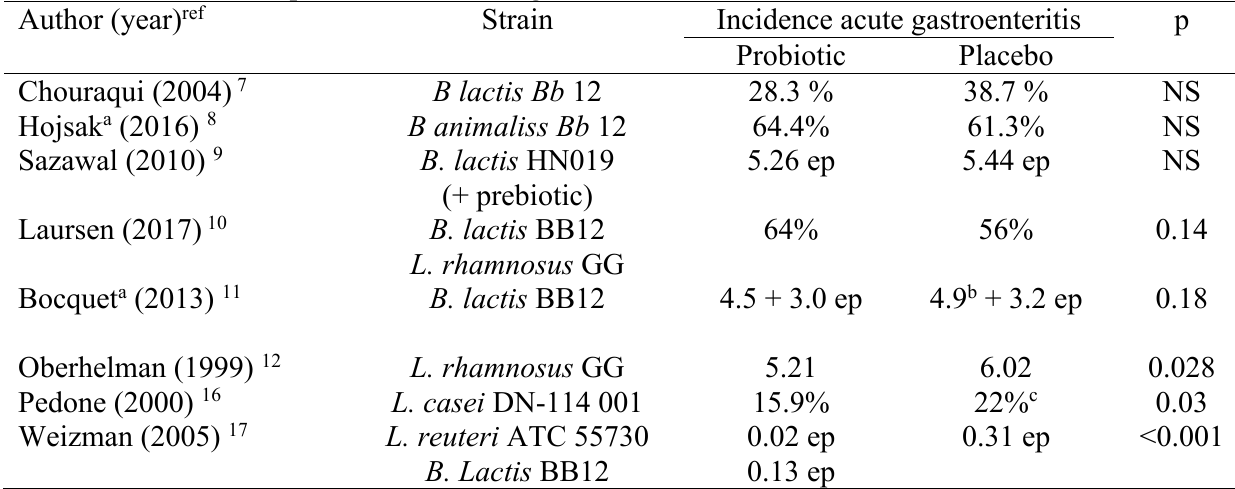
Table 1. Probiotics and prevention of acute gastroenteritis Author (year) ref